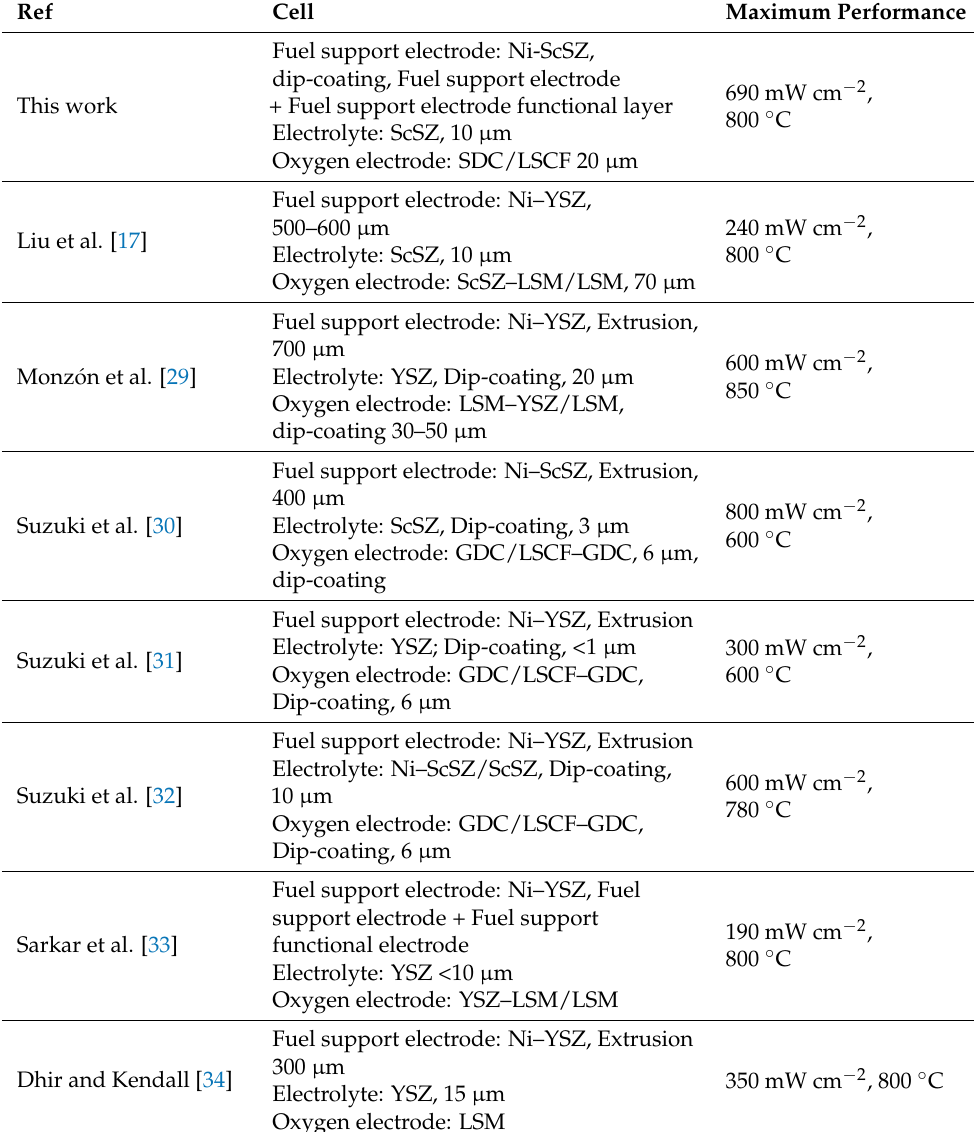
Table 2. Performance summary of fuel electrode supported